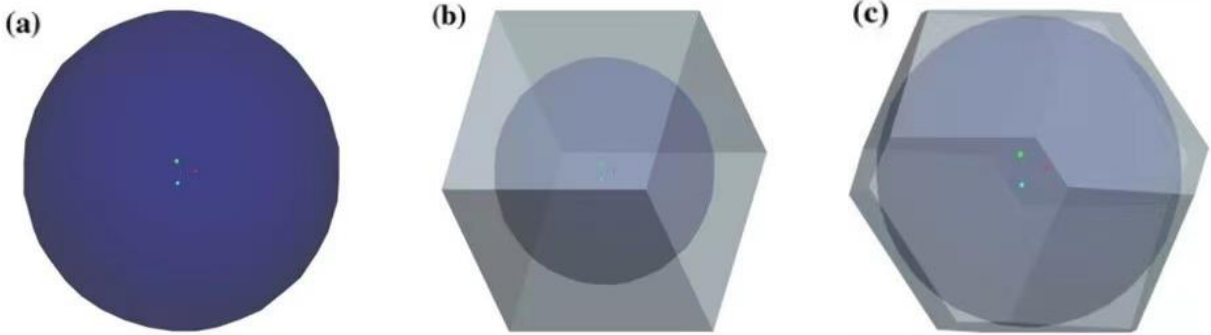
Figure 9. Corresponding HGM superimposed elements ( a ) Single; ( b ) Cubic; ( c ) Hexagonal HGM superimposed element. ( a-c ) Adapted with permission [54], Copyright 2018, MDPI.